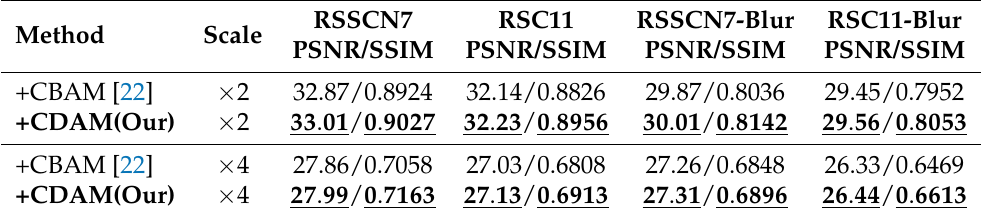
Table 3. Quantitative comparison of our CDAM and CBAM. Our CDAM results are highlighted , and the best results are